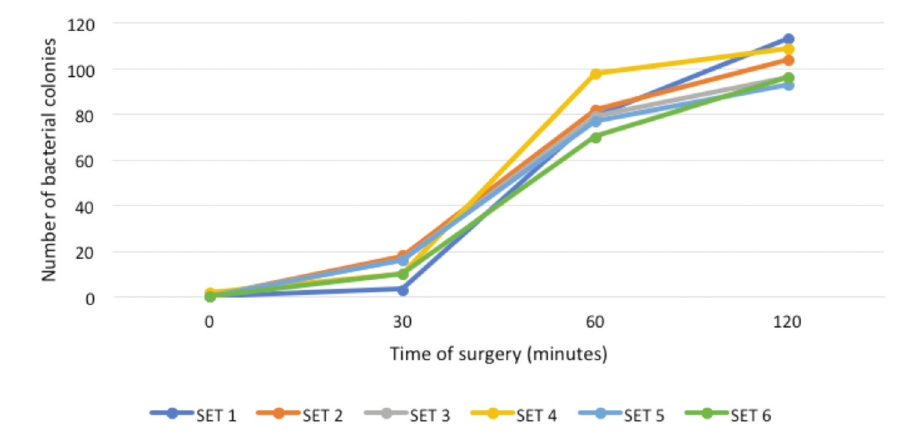
Graph showing total bacterial count (colonies) according to time of surgery. Fig. 1: